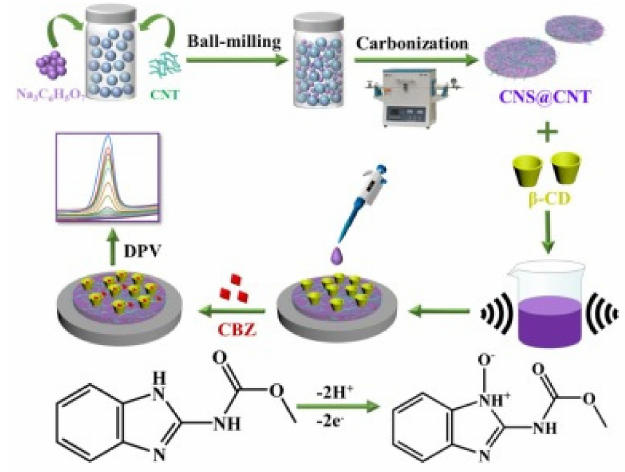
Figure 3. Fabrication of the β -CD/CNS@CNT/GCE sensor for the determination of CBZ (Reprinted from [99] with permission from